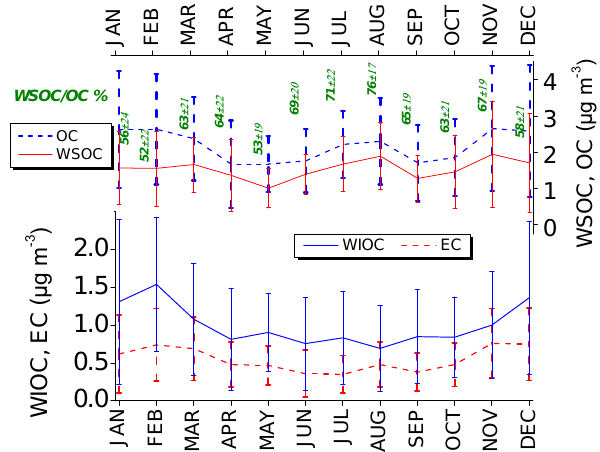
Figure 4. Average seasonal cycle of the OC / EC ratio calculated from daily values for the period May 2008–April 2013.